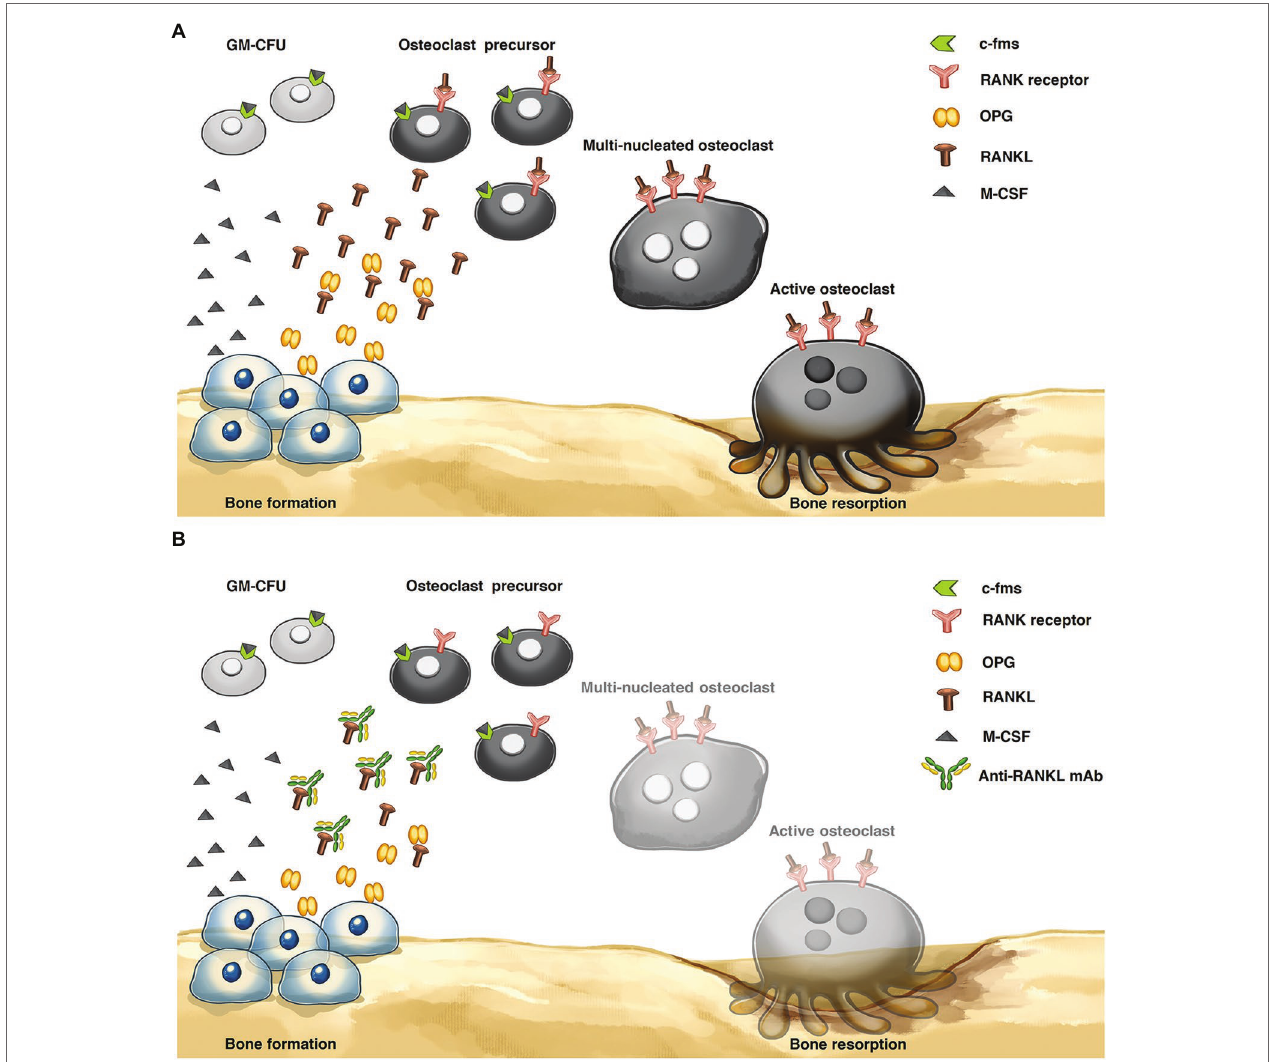
FIGURE 1 | Bone remodeling process (A) Osteoclastic bone resorption pathway. Osteoblasts express receptor activator of nuclear factor- κ B ligand (RANKL), and RANKL binds to the RANK receptor on the osteoclast precursor surface, inducing active osteoclasts. Osteoprotegerin (OPG) plays an important role in inhibiting the interaction of RANKL and RANK receptors to reduce osteoclast differentiation. (B) Mechanism of anti-RANKL mAb. The levels of osteoclast differentiation and activity were decreased via an anti-RANKL mAb, preventing the interaction between the RANKL and RANK receptors. Granulocyte-macrophage-colony-forming cell (GM-CFU), macrophage-colony-stimulating factor (M-CSF), and colony-stimulating factor-1 receptor